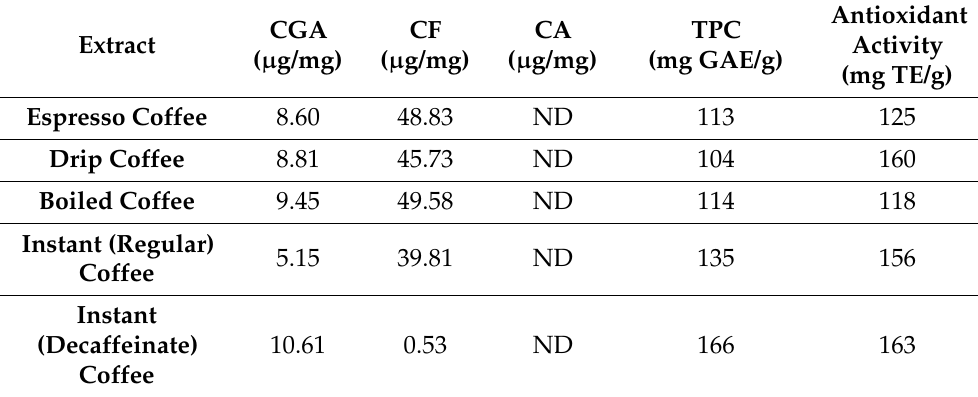
Table 1. Average values of chlorogenic acid, caffeine, total phenolic contents and antioxidant activity in coffee